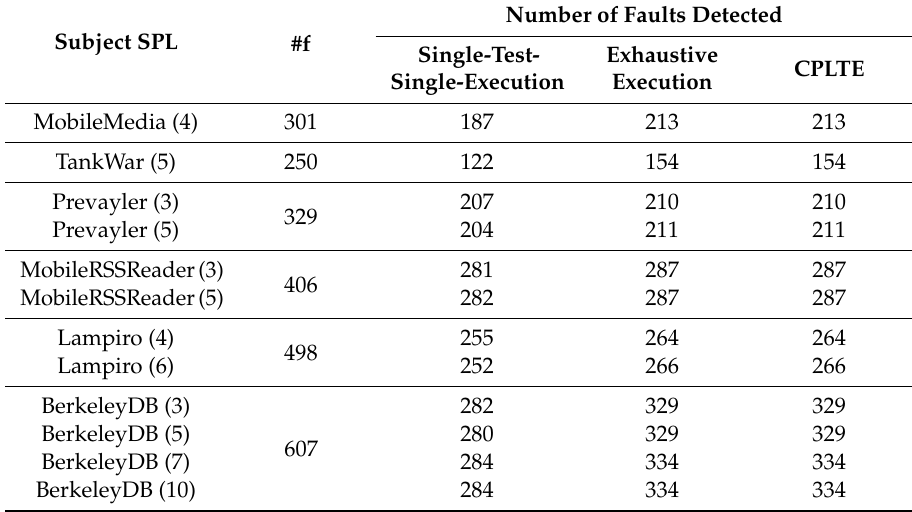
Table 5. Number of faults detected by the single-test-single-execution, the exhaustive execution and